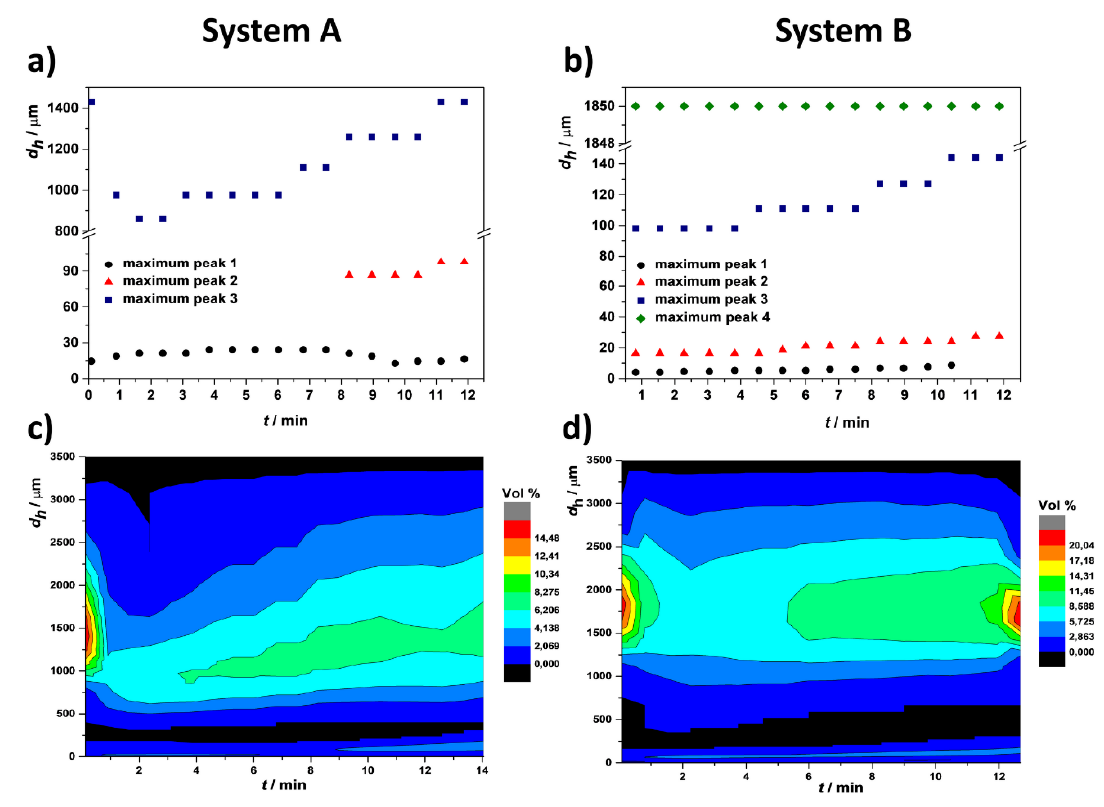
Figure 5. Changes of hydrodynamic diameter ( d h ) ( a – b ) and vol. % ( c – d ) of particles formed in system A ( c (CaCl 2 · 2H 2 O) = c (Na 2 HPO 4 ) = 3.5 mmol dm − 3 ) and B ( c (CaCl 2 · 2H 2 O) = c (Na 2 HPO 4 ) = 4.0 mmol dm − 3 ) with mechanical stirring measured by LD. pH init = 7.4, ϑ = 25.0 ± 0.1 °C.